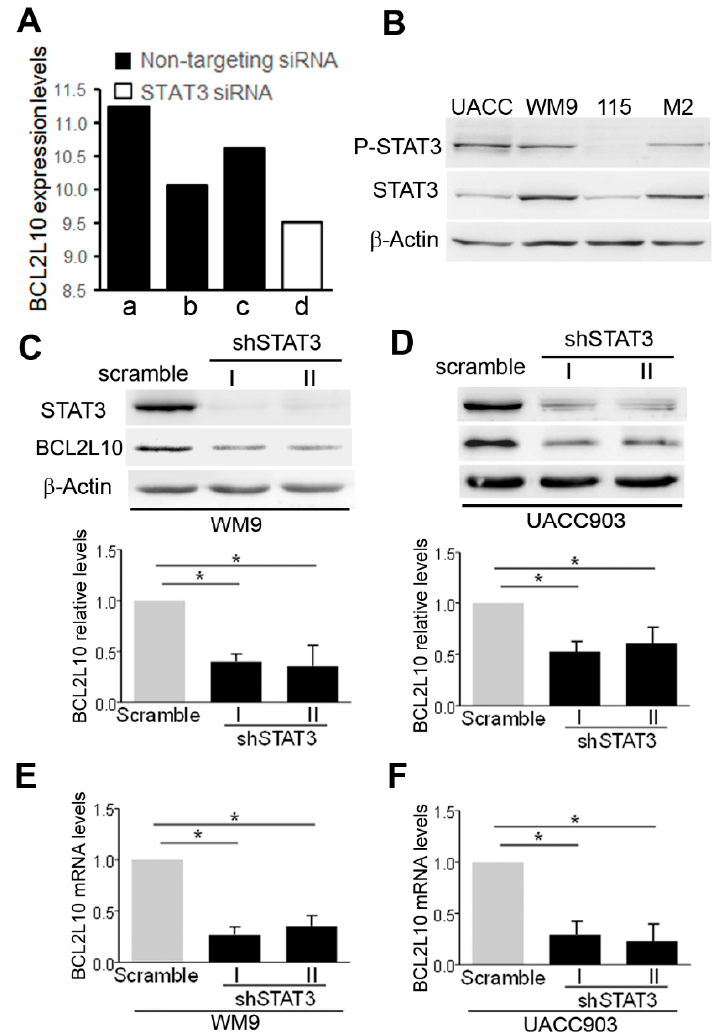
Figure 3. Silencing of STAT3-reduced BCL2L10 expression. ( A ) Regulation of BCL2L10 by STAT3 in dataset GSE31534. Analysis of dataset GSE31534 showed that a STAT3 siRNA (column d, GSM782740) reduced BCL2L10 mRNA levels in A375 melanoma cells compared to non-targeting siRNA (columns a to c: GSM782733, GSM782734, and GSM782735, respectively). ( B ) Phosphoryla- tion of STAT3 at Tyr 705 in melanoma cell lines. Protein extracts from UACC903 (UACC), WM9,